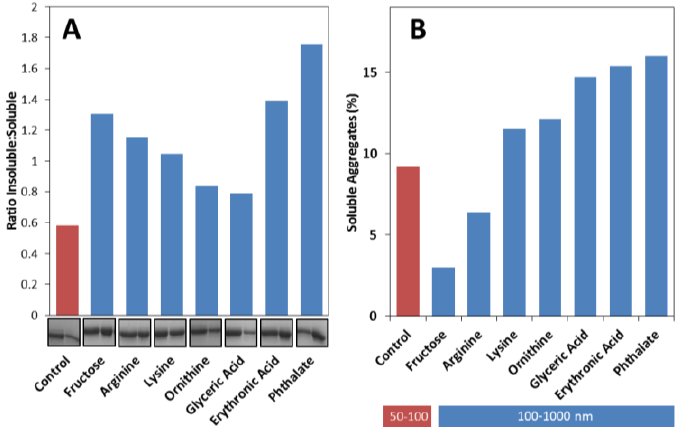
Figure 5. Metabolites influence apoSOD1 aggregation towards insoluble aggregates and increase the size of soluble aggregates. ( A ) Ratio of soluble and insoluble aggregates formed from 50 μM apoSOD1 with 200 μM of each metabolite. SDS-PAGE gel: first band correspond to soluble aggregates and second band corresponds to insoluble aggregates, after incubation of apoSOD1 under agitation at 37 °C for 200 h; ( B ) DLS size distribution of soluble aggregates of apoSOD1 alone and with 200 μM of each metabolite after incubation at pH 7.4 under agitation at 37 °C for 200 h. Red bar correspond to apoSOD1 particles (50–100 nm) and blue bars correspond to larger aggregates formed in the presence of metabolites (100–1000 nm). See experimental section for further